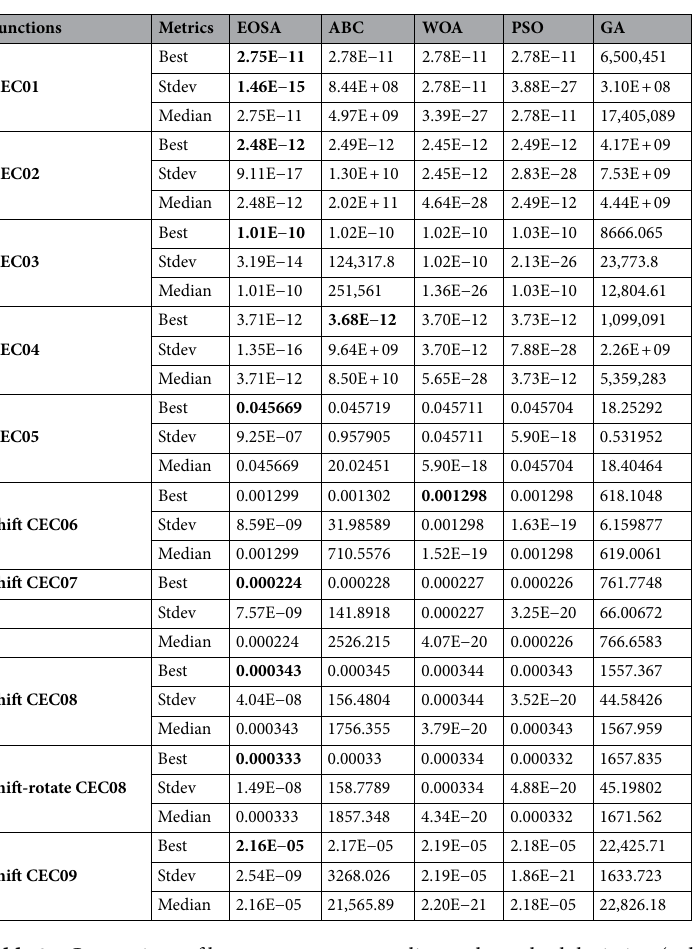
Table 8. Comparison of best, worst, mean, median and standard deviation (stdev) values for EOSA, ABC, WOA, PSO, and GA metaheuristic algorithms using the constrained IEEE CEC-2017 benchmark functions over 500 epochs and 100 population size.